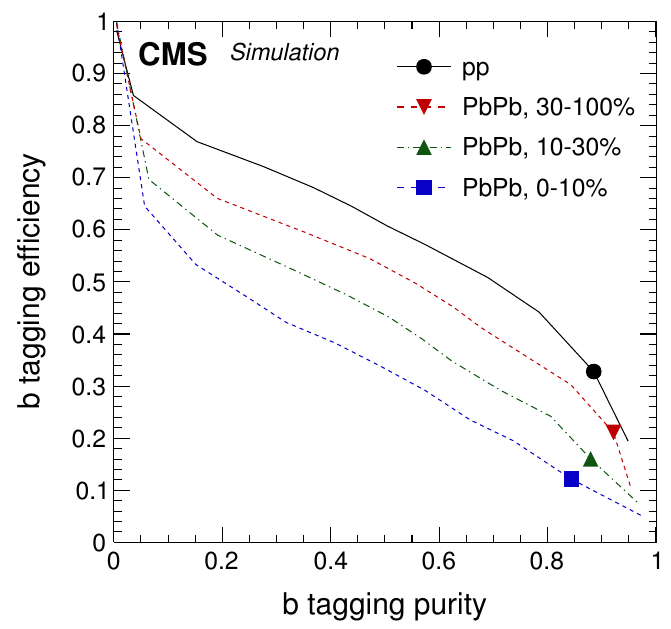
Figure 1 . The b dijet purity vs. e(cid:14)ciency as a function of the value of the selection on the CSV discriminator in simulation. The same CSV selection is applied to both jets. Several di(cid:11)erent centrality intervals of PbPb, as well as pp collisions, are shown, as indicated in the legend. The closed symbols indicate the working point used in this